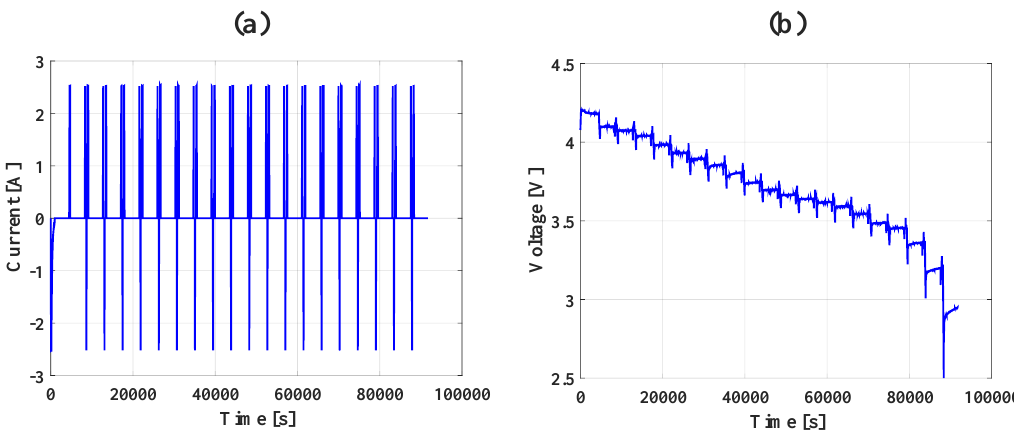
Figure 5. The HPPC test procedure: ( a ) engaged current profile and ( b ) resulting terminal voltage.